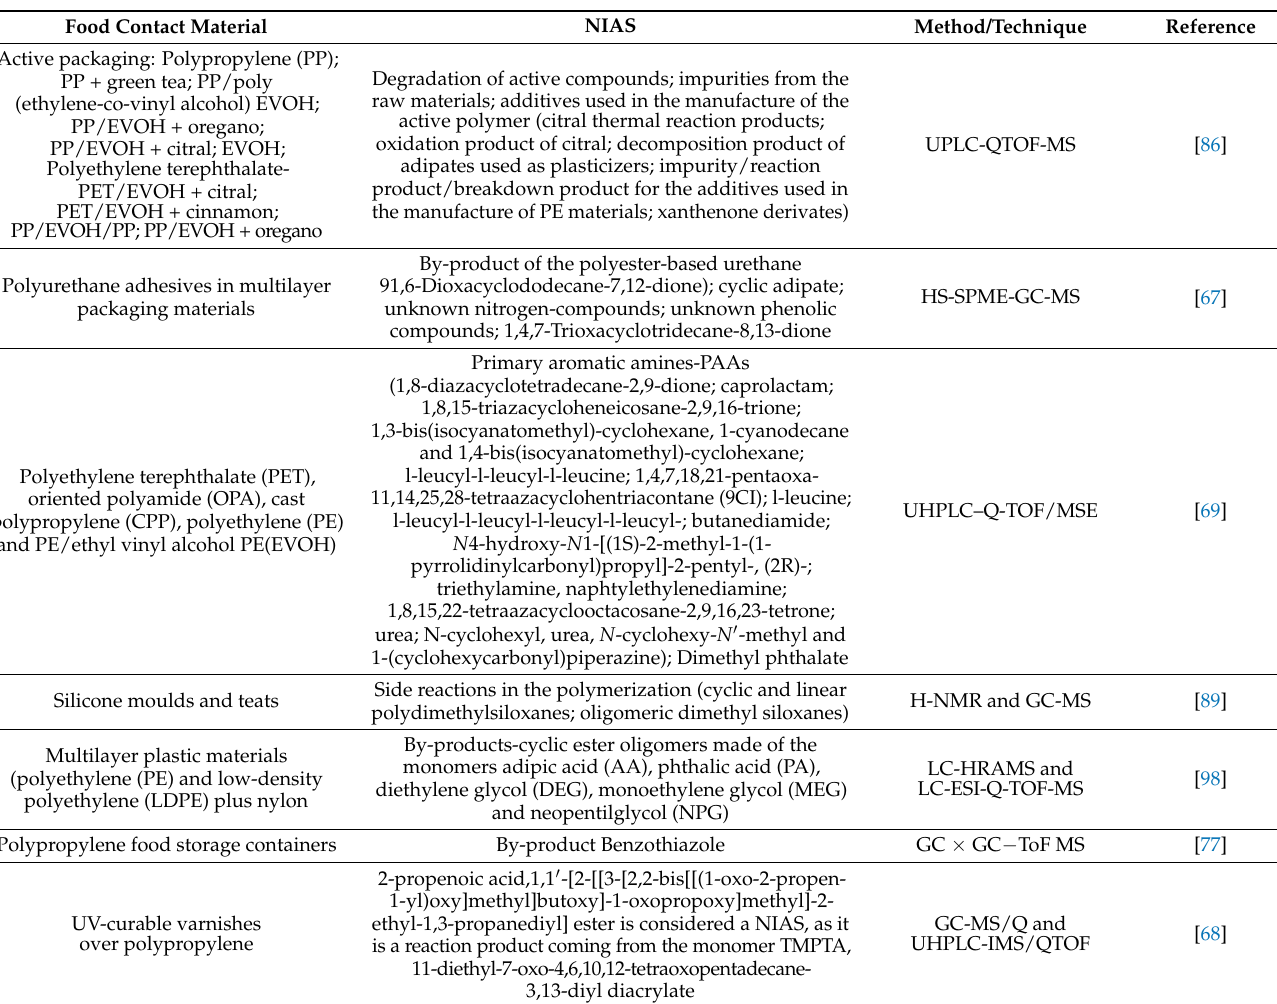
Table 3. Studies published in the literature on by-products/side reaction products (NIAS) Identification in different plastic food